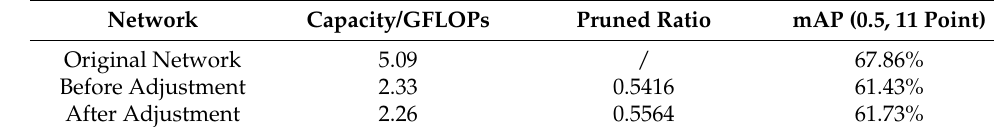
Table 3. Some indicators before and after pruning rate adjustment.